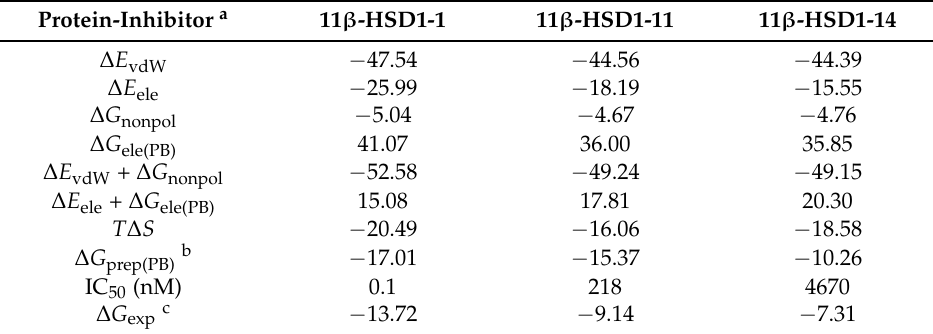
Table 2. Binding free energy and its components for the studied complexes. Protein-Inhibitor